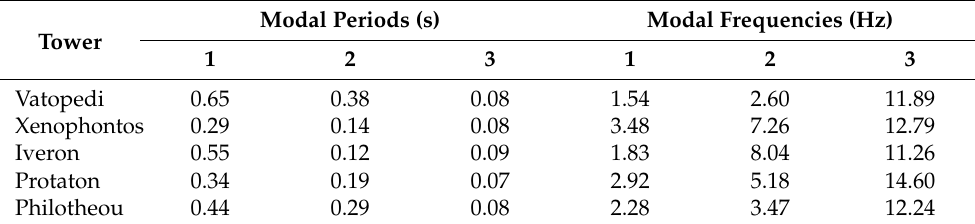
Table 3. Modal frequencies and periods of towers.